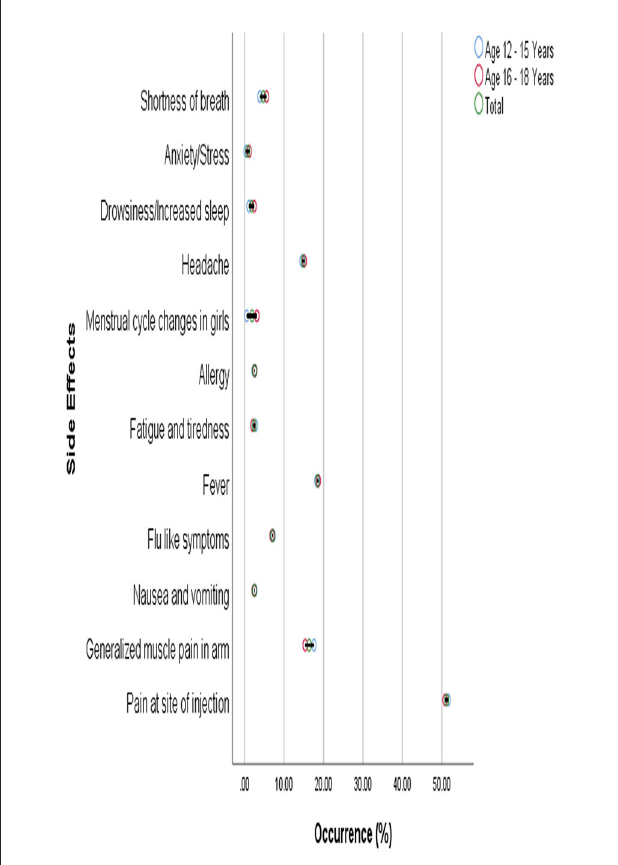
FIGURE5 Age distribution of reported side effects after the first